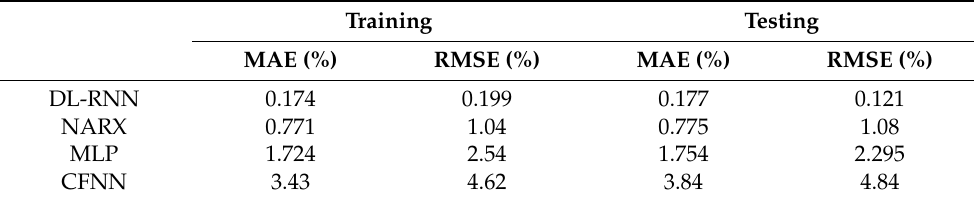
Table 4. Performance comparison of different methods (FD001 dataset).